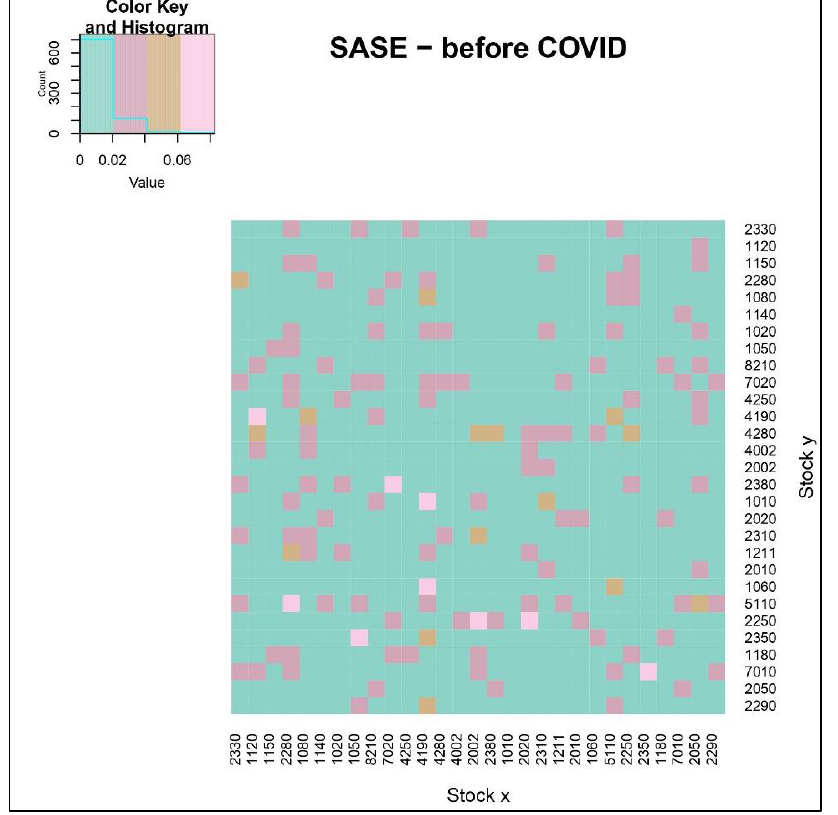
Figure 17. The information flow (effective transfer entropy) from stock y to stock x, for the top companies (by market capitalization) in the SASE market, before the COVID-19 outbreak